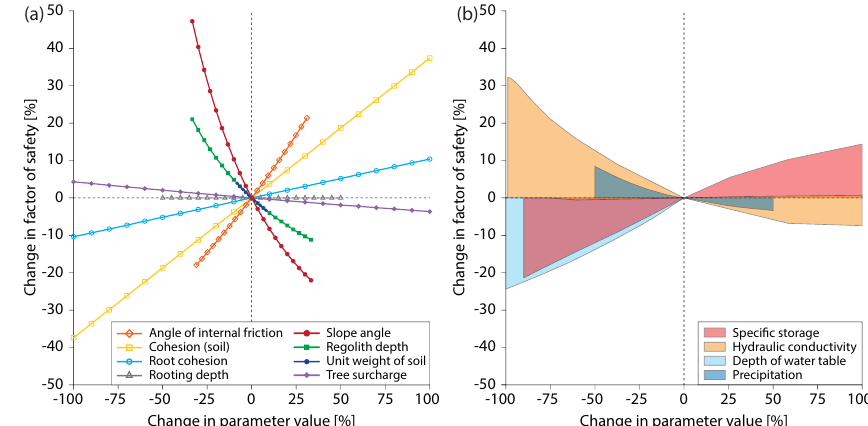
Figure 8. OAT sensitivity of the model results (change in factor of safety) for tested parameter value ranges for the geomechanical model element (a) and the hydrological model element (b) . Respective parameter values are listed in Table